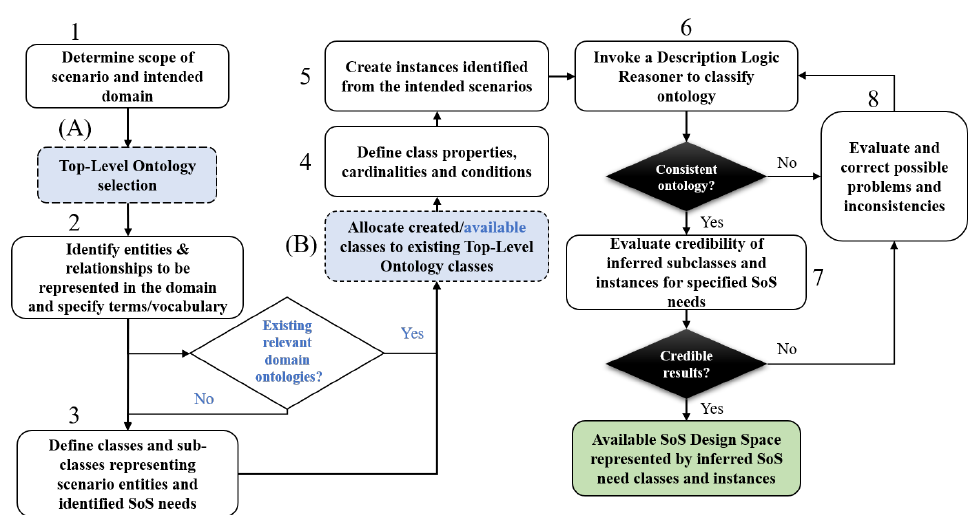
Figure 6. The ontology development process described in [37], with its eight consecutive